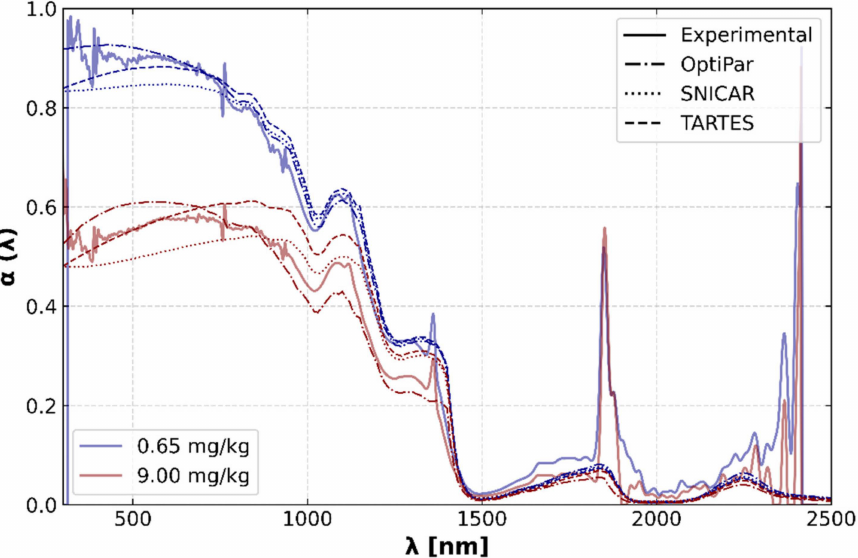
Figure 8. Comparison of experimental with modelled albedo (with OptiPar, SNICAR and TARTES) for 0.65 and 9.0 mg/kg soot. For SNICAR and TARTES simulations of spherical snow grains were